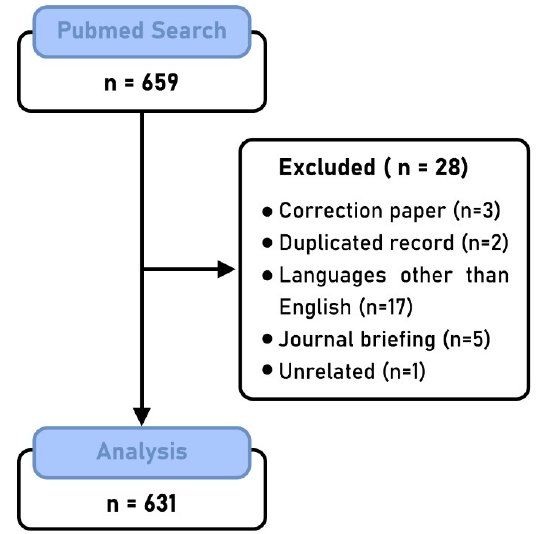
Figure 1. Flow diagram of the articles analyzed in the study.